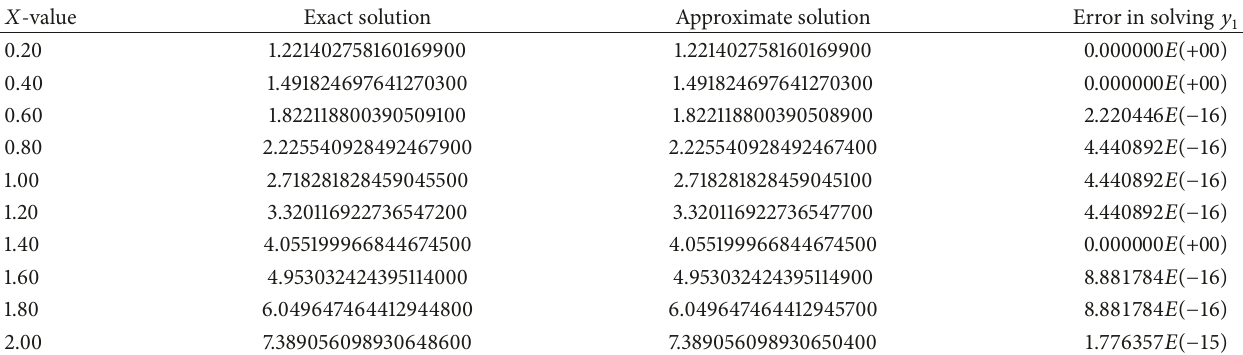
Table 5: Exact and approximate solutions for solving 𝑦 1 using the developed